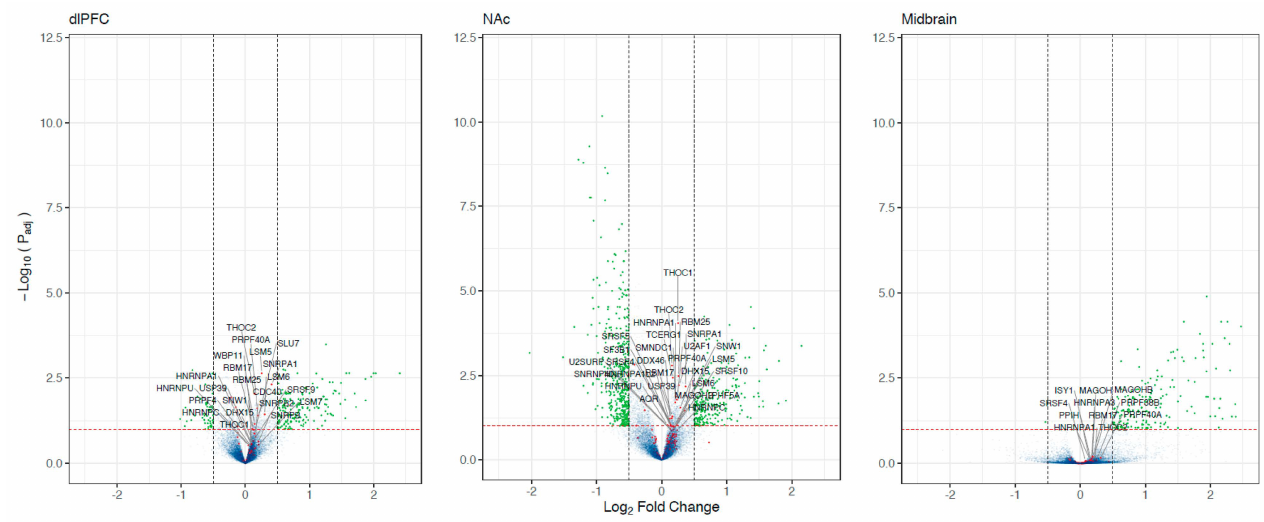
Figure 4. Spliceosome disrupted in the brains of individuals with OUD. A) Volcano plots showing results from differential expression analyses of OUD vs. the controls. The X-axis shows the Log 2 Fold change and the y-axis indicates the level of significance log 10 (P adj ). Each dot corresponds to a transcript. Green dots are significant (P adj < 0.10 and |Log 2 Fold Change| > 0.5), red dots are spliceosome genes. The most significant spliceosome genes are labeled.